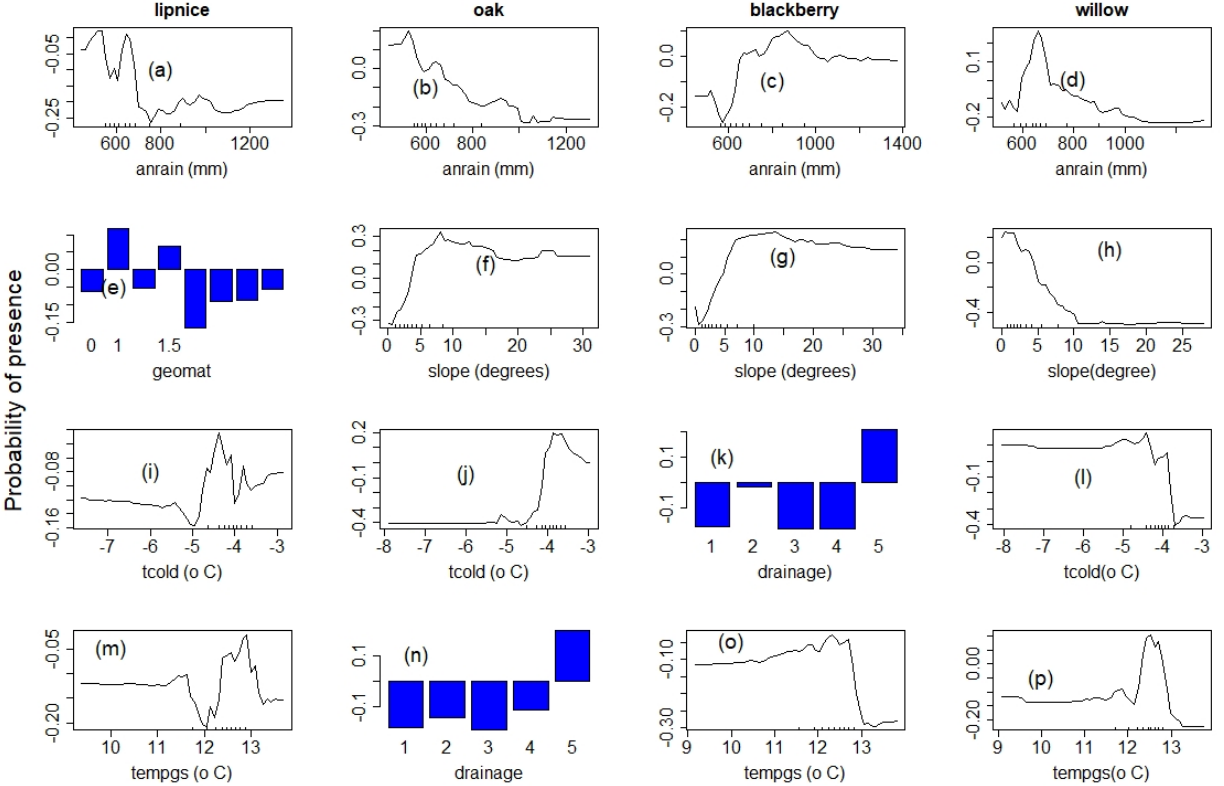
Figure 6. Species response climate and environmental gradient: panel 1: lipnice; panel 2: oak; panel 3: blackberry; panel 4: willow; “anrain” = annual rainfall; “tcold” = average minimum tempera-ture; “tempgs” = temperature of the growing season; “lenvgt” = length of the vegetation period; and “geomat” = geological material. ( a – d ) annual rainfall, ( e , o ) average minimum temper-ature, ( e ) geological material scaled from 0 for very coarse to 1.9 for very fine material, ( f – h ) slope angle, ( i , j , l ) average minimum temperature, ( k , n ) soil drainage scaled from 1 for poorly drained to 5 for well-drained soils, ( m , o , p ) average temperature of the growing